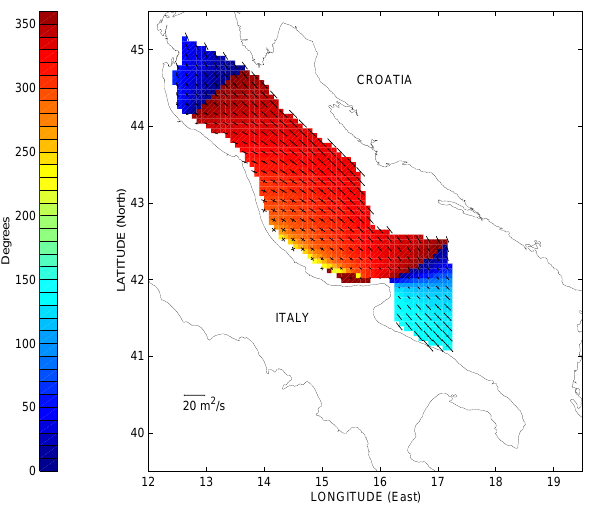
Fig. 8. M2 tidal phase and ellipses calculated from vertically aver- aged ADCP data for the winter season. Phase corresponds to times when the semi-major axis is in the first or the fourth trigonometric quadrant.